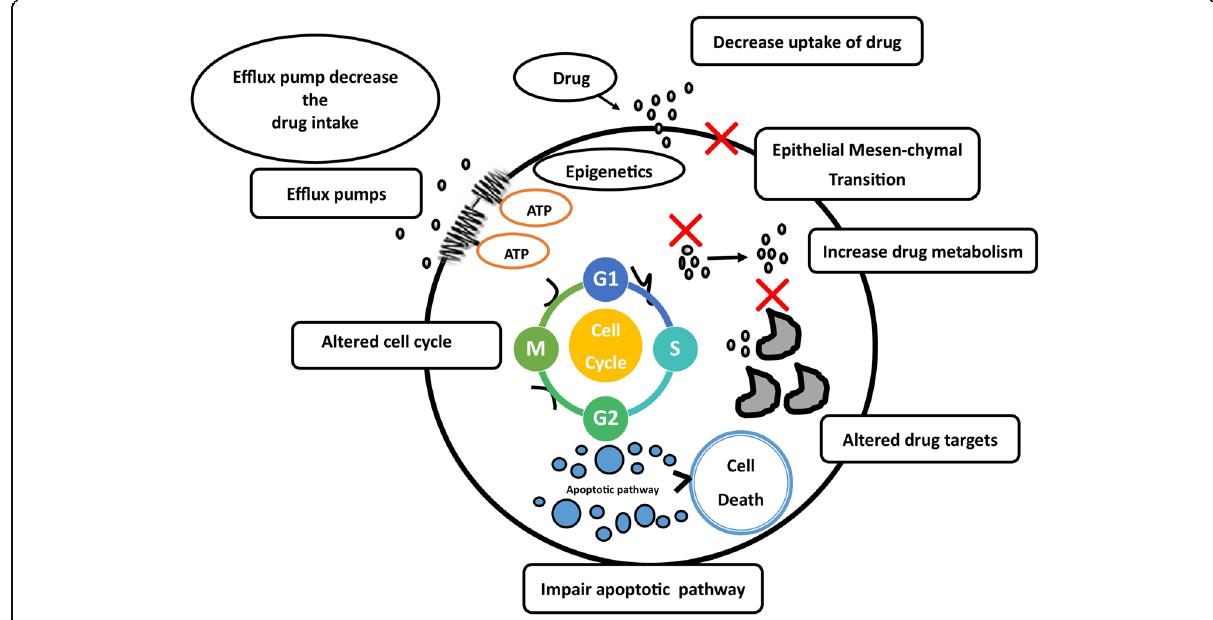
Fig. 5 Various mechanisms of drug resistance in